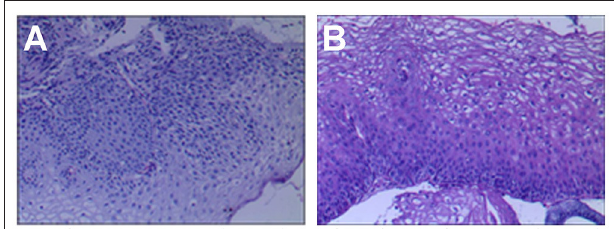
FIGURE 2 | Histopathological examination before and after REBACIN ® treatment. (A) Before REBACIN ® treatment, the patient was diagnosed as CIN2 via the histopathology of cervical biopsy, showing a moderate atypical hyperplasia. The cells including obvious atypia cells were arranged disorderedly; the abnormally proliferating cells occupied 2/3 of the subepithelial layer. (B) After two courses of REBACIN ® treatment, the patient was diagnosed as CIN1, showing a mild atypical hyperplasia. The cells including some atypia cells were arranged irregularly, but still maintained polarity. The abnormally proliferating cells are limited to the lower 1/3 of the subepithelial